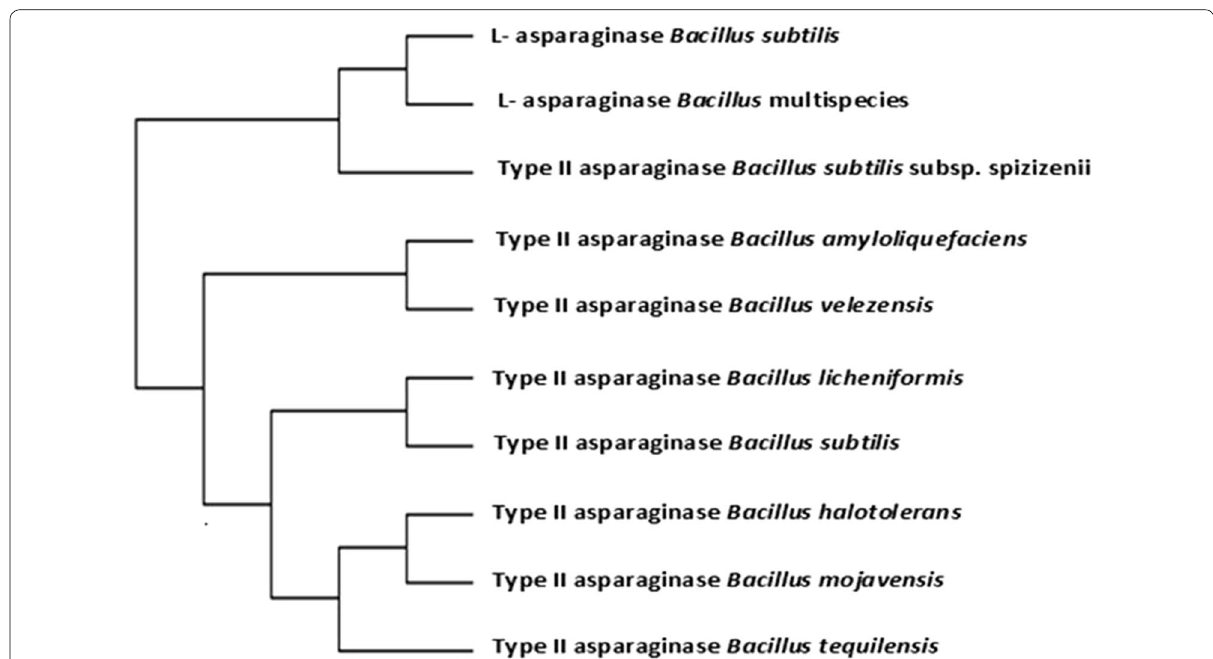
Fig. 1 Molecular phylogenetic analysis by maximum likelihood method of Bacillus licheniformis l -asparaginase (accession WP_075750324) as compared to those retrieved by blasting the query sequence against amino acid sequences deposited in NCBI databases. l -asparaginases presented in the tree are non-redundant ones with amino acids sequence similarities not less than 74%